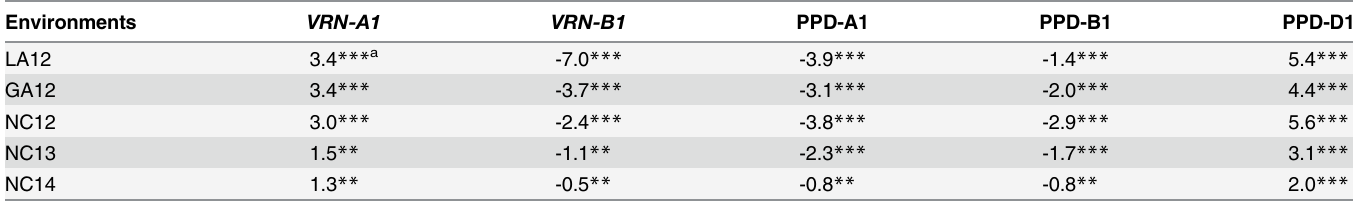
Negative values indicate that the AGS 2000 alleles confer earlier fl owering at fi eld locations; Baton Rouge, LA, 2012; LA12, Plains, GA, 2012; GA12 Raleigh, NC, 2012; NC12, 2013; NC13, 2014; NC14. a